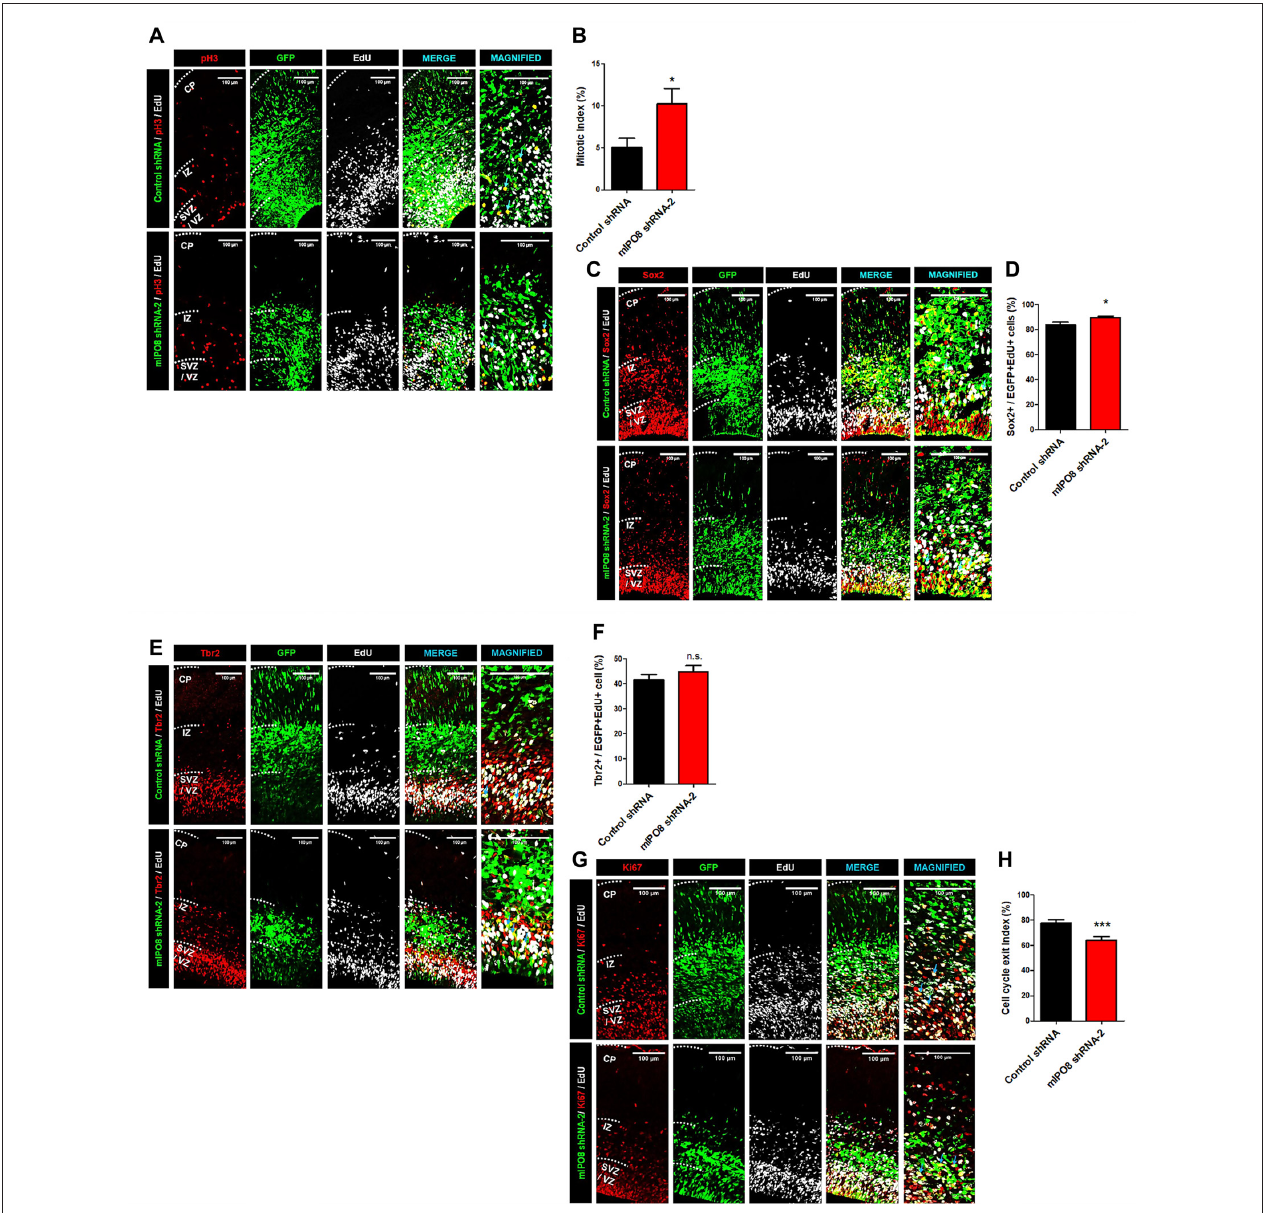
FIGURE 3 | Ipo8 knockdown affects cell proliferation and cell cycle exit of apical progenitor (AP) population. (A,B) Analysis of the mitotic index. IUE was performed at E13.5 with control shRNA or mIPO8 shRNA-2. Mice were injected i.p. with EdU 1 h before sacrifice at E15.5. (A) Immunolabeling for EGFP (green), EdU (gray) and pH3 (red), a mitotic marker. (B) Quantification of the mitotic index (number of EGFP+/EdU+/pH3+ cells divided by the number of EGFP+EdU+ cells). (C,D) . Analysis of the AP pool. The experimental conditions were the same as in (A) . (C) Immunolabeling for EGFP (green), EdU (gray) and Sox2 (red), the AP marker. (D) Quantification of the proportion of neurons expressing Sox2 among the EGFP+/EdU+ population. (E,F) Analysis of the Basal progenitor (BP) pool. The experimental conditions were the same as in (A,B) . (E) Immunolabeling for EGFP (green), EdU (gray) and Tbr2 (red), a BP marker. (F) Quantification of the proportion of neurons expressing Tbr2 among the EGFP+/EdU+ population. (G,H) Analysis of the cell cycle exit index. IUE was performed at E13.5 with control shRNA or mIPO8 shRNA-2. Mice were injected i.p. with EdU 24 h before the sacrifice at E15.5. (G) Immunolabeling for EGFP (green), EdU (gray) and Ki67 (red), a proliferation marker. (H) Quantification of the cell cycle exit index (number of EGFP+/EdU+/Ki67 − cells among the EGFP+/EdU+ population). The blue arrows show triple stained cells. The neurons were counted in the VZ/SVZ and IZ. VZ/SVZ, ventricular/subventricular zone; IZ, intermediate zone; CP, cortical plate; ∗ p < 0.05, ∗∗∗ p <